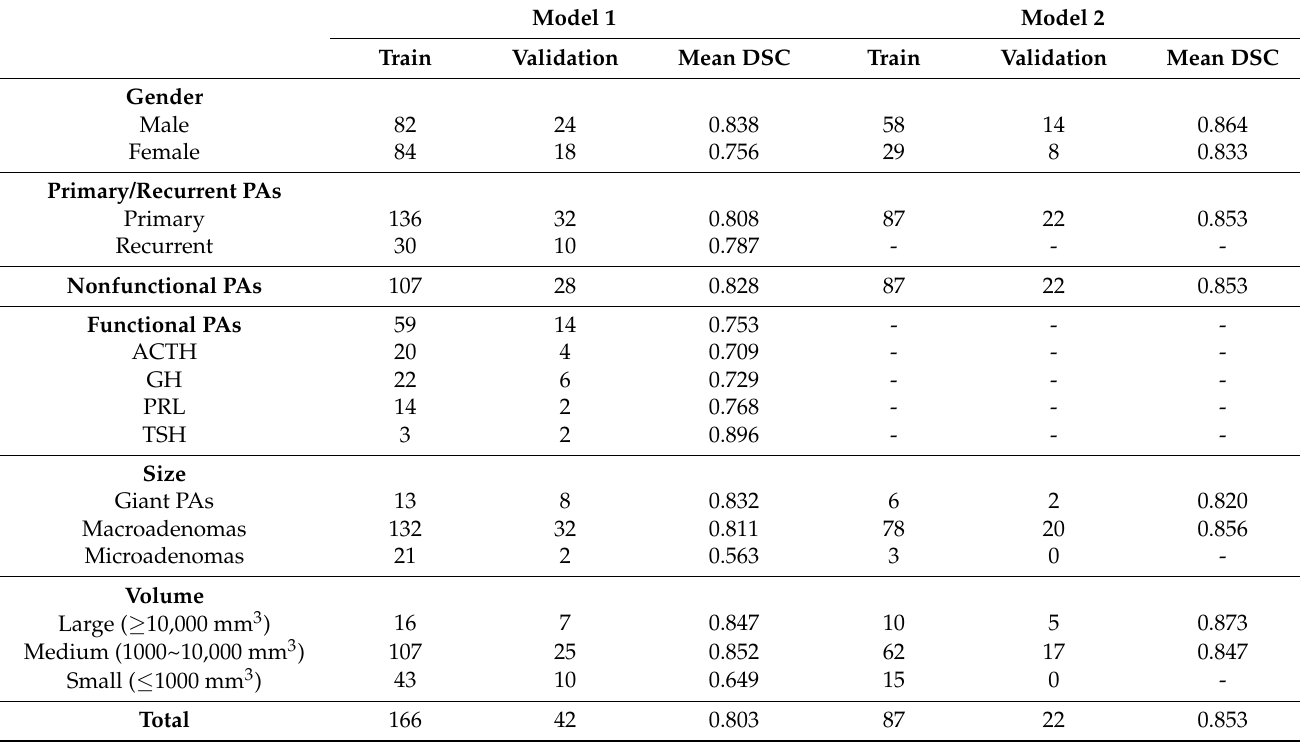
Table 2. The mean Dice Similarity Coefficient (DSC) on validation dataset of both